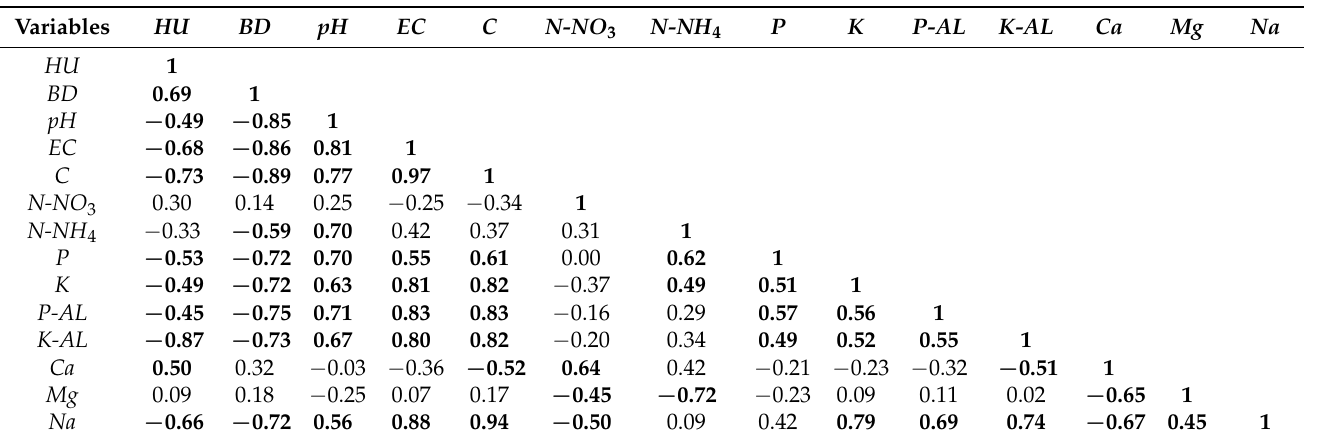
Table 3. Correlation